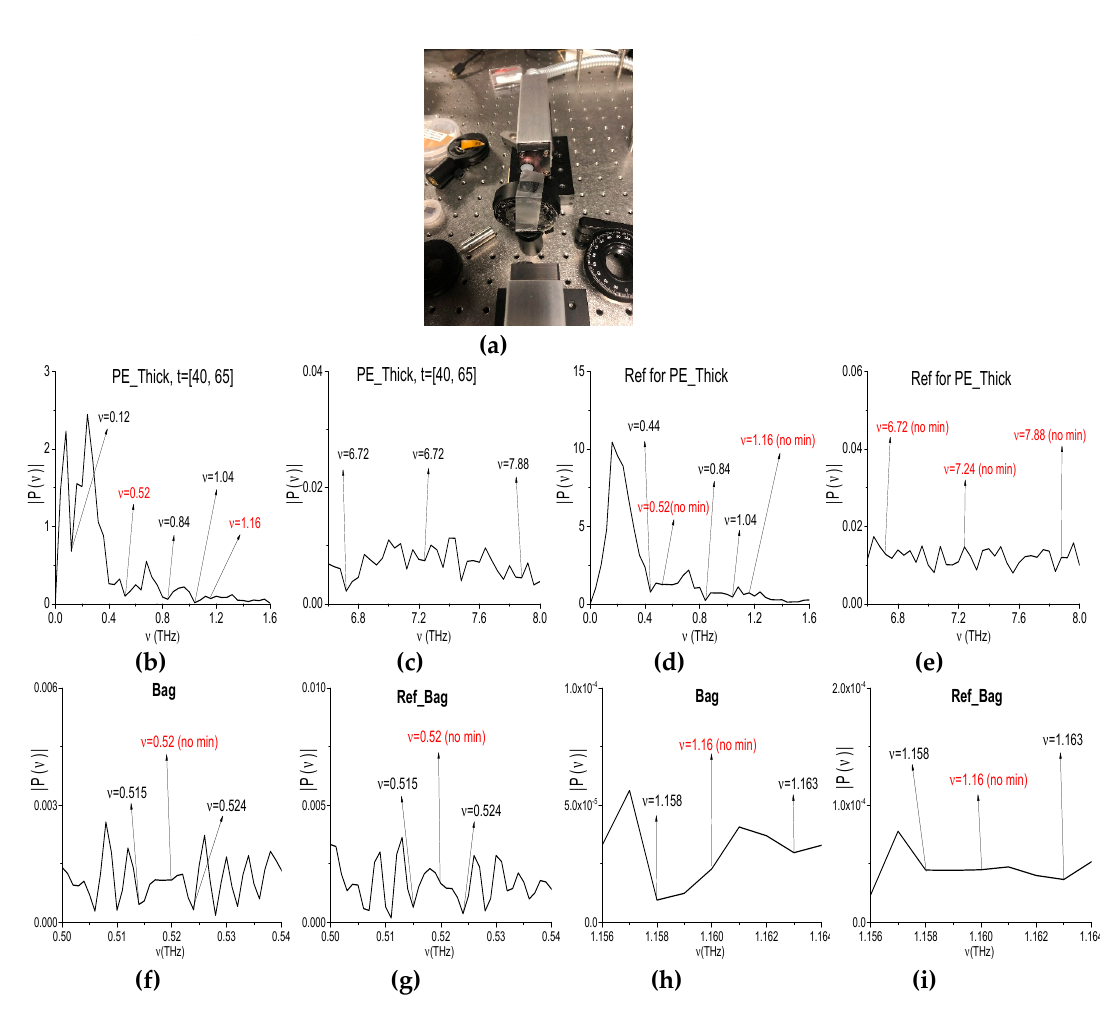
Figure 20 . Empty polyethylene bag (a) in the THz setup. The spectrum of the broadband PE_Thick Figure 20. Empty polyethylene bag ( a ) in the THz setup. The spectrum of the broadband PE_Thick pulse (b,c) and the reference spectrum (d,e) in the frequency ranges ν = [0, 1.6] THz (b,d) [6.6, 8.0] pulse ( b , c ) and the reference spectrum ( d , e ) in the frequency ranges ν = [0, 1.6] THz ( b , d ) [6.6, 8.0] THz THz (c,e). The spectrum of the narrowband Bag signal (f,h) and the reference spectrum (g,i) in the ( c , e ). The spectrum of the narrowband Bag signal ( f , h ) and the reference spectrum ( g , i ) in the frequency ranges ν = [0.5, 0.54] THz ( f , g ), [1.156, 1.164] THz ( h , i frequency ranges ν = [0.5, 0.54] THz (f,g), [1.156, 1.164] THz (h,i).